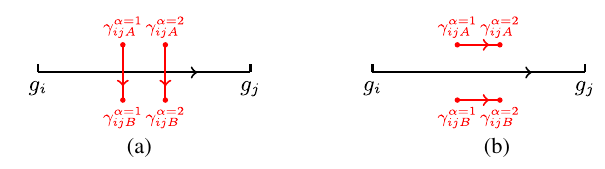
FIG. 13. There are n 0 ¼ 2 effective Majorana chains ( α ¼ 1 ,